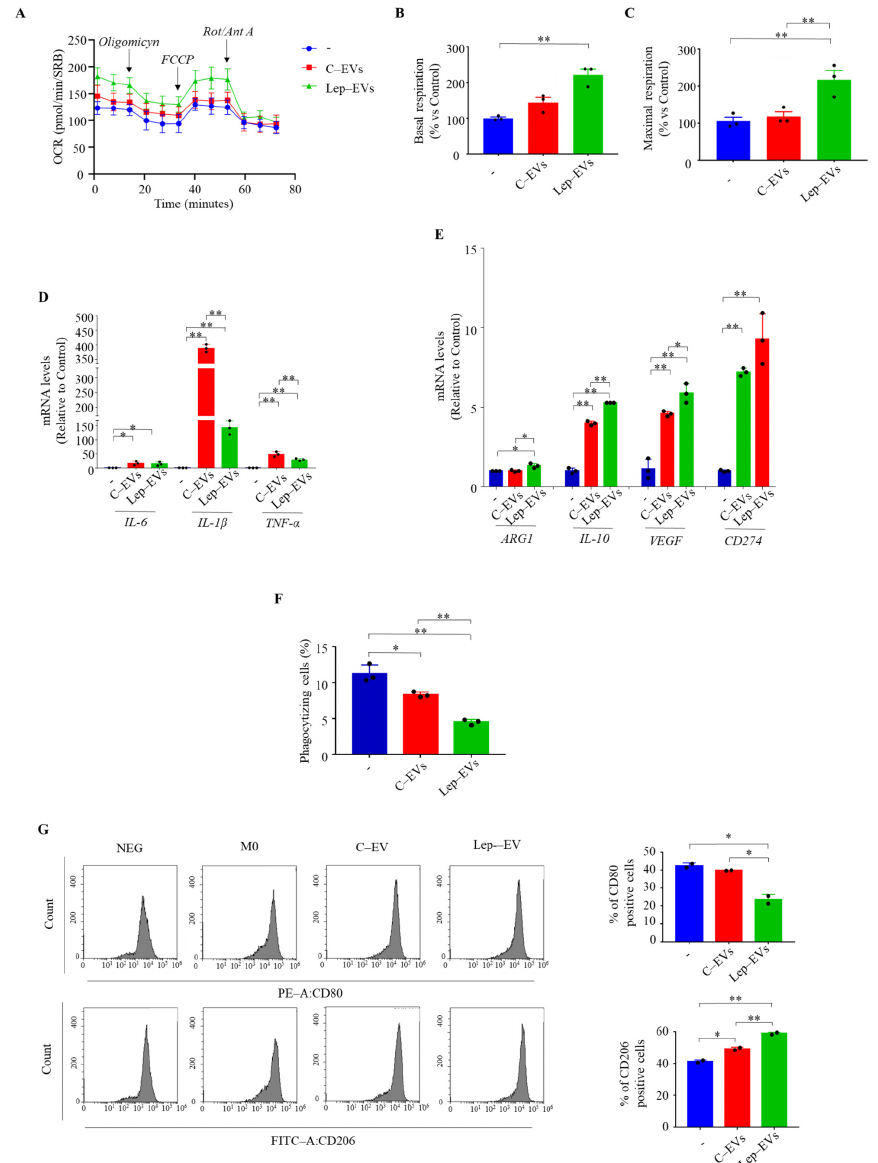
Figure 6. Lep-EVs support the M2-like pro-tumoral macrophage phenotype. THP-1 cells were stimulated with phorbol 12-myristate 13-acetate (PMA, 100 nM) for 24 h followed by 24 h rest to obtain THP-1 macrophage-like cells (M0). The mitochondrial metabolic profile of M0 macrophages untreated (–) or treated with C-EVs and Lep-EVs (2 µ g/mL) for 48 h was assessed using the Seahorse Xfe-96 analyzer. A schematic tracing of OCR flux ( A ) and graphic representation of the basal respiration ( B ) and maximal respiration ( C ) were reported. Data represent the mean ± SEM of five biological replicates of three independent experiments and normalized by protein content (SRB assay). ( D , E ). Real-time RT-PCR assay for interleukin (IL)-6, IL-1 β , Tumor Necrosis Factor alpha ( TNF- α ), arginase-1 ( ARG1 ), IL-10 , Vascular Endothelial Factor ( VEGF ), cluster of differentiation 274 ( CD274 ), in M0 untreated (–) or treated with C-EVs and Lep-EVs (2 µ g/mL) for 48 h. ( F ) M0 macrophages treated as above were incubated with latex beads conjugated with FITC-IgG for 2 h and results were expressed as percentage of phagocytizing cells. ( G ) Flow cytometry analyses of M1 marker CD80 and M2 marker CD206 in M0 macrophages untreated or treated with C-EVs and Lep-EVs for 48 h. The bars represent the percentages of positive cells. Each circle represents one independent experiment. The values represent the mean ± SD of two/three different experiments, each performed in triplicate. * p ≤ 0.05; ** p ≤